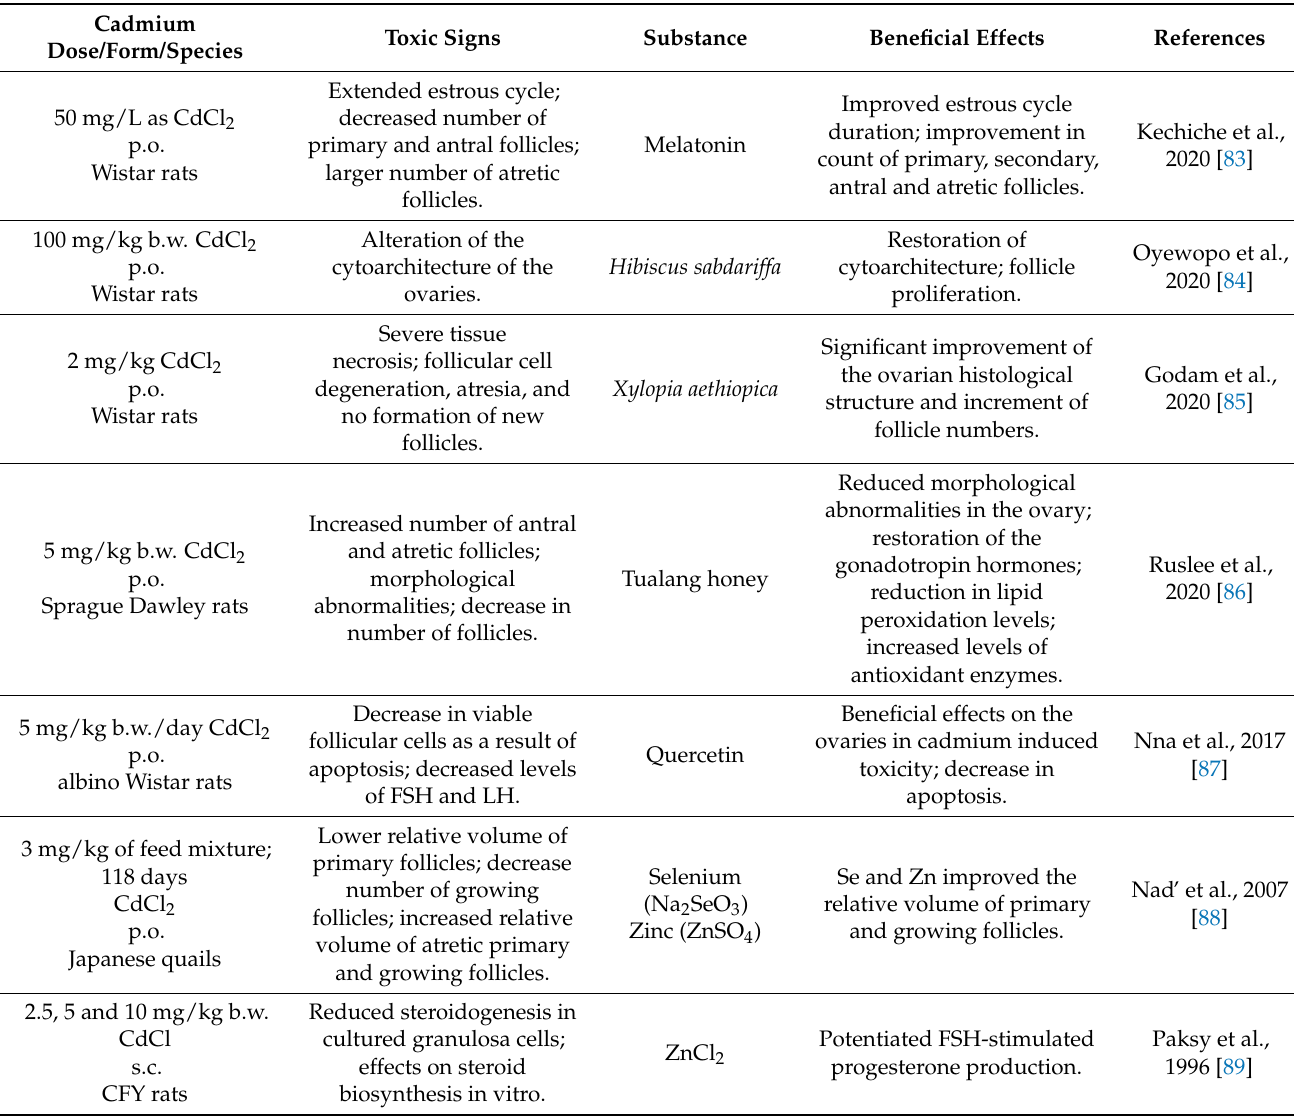
Table 4. Experimental ameliorating ovarian cadmium